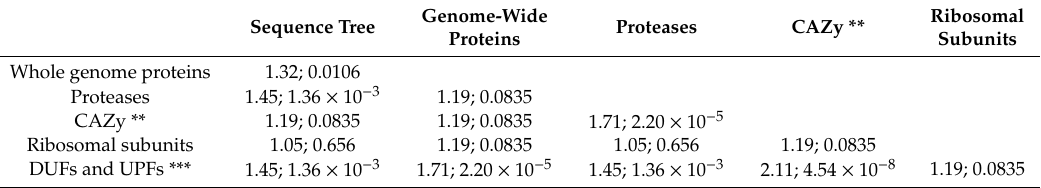
Table 1. Congruence tests among the sequence and selected protein family size-based trees